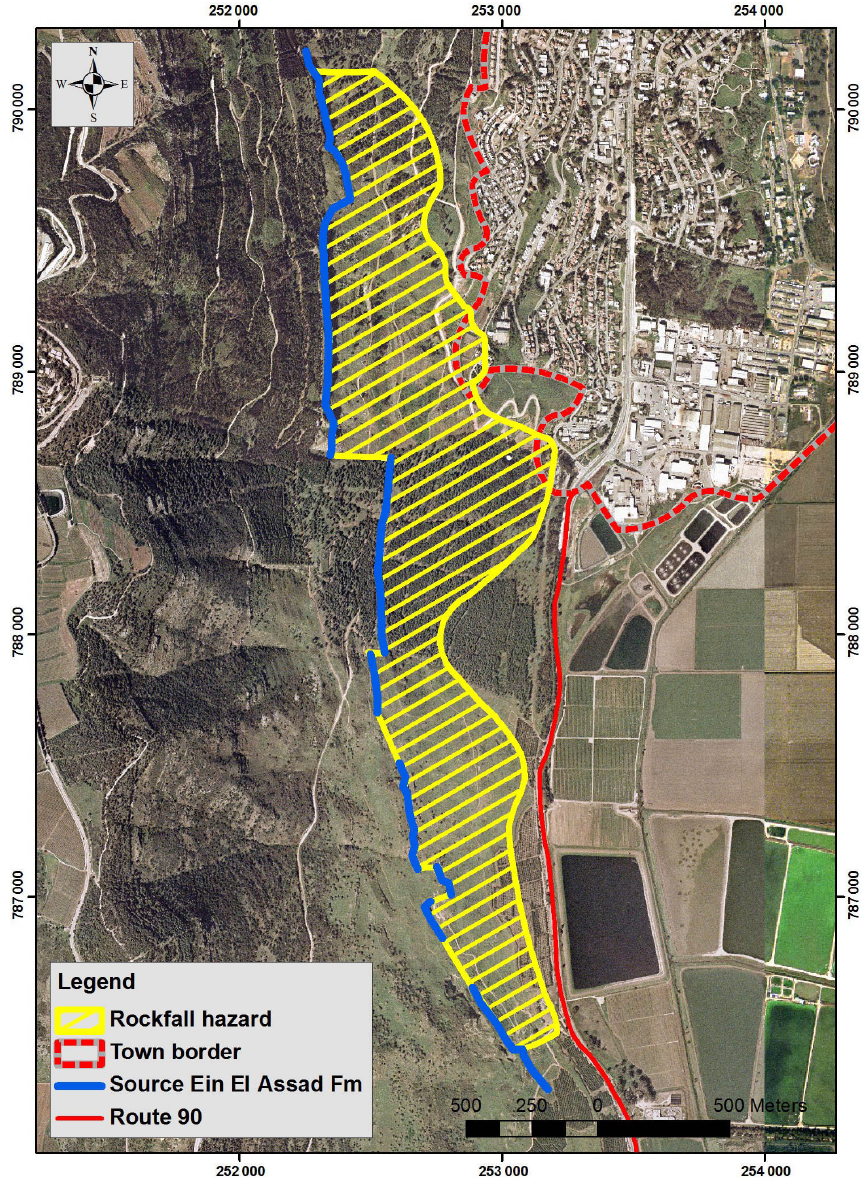
Figure 8. Rockfall hazard map of the study area. The area subject to rockfall hazard is defined from the source escarpment to 100% stop line. Map compiled from maximal travel distance of 25 rockfall simulation profiles performed using CRSP (green lines in Fig.